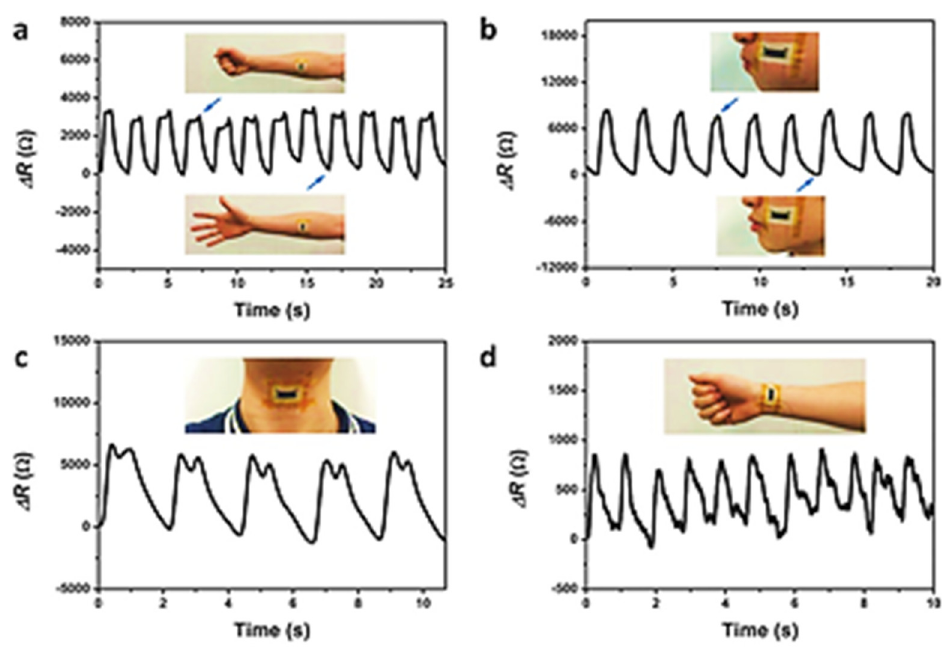
Figure 2. Application of the AuNWs/latex strain sensor in human motion monitoring: ( a ) movement of the forearm muscles; ( b ) movement of the cheeks; ( c ) continuous throat movement while saying “hello”; and ( d ) detecting human wrist pulses [66]. Copyright 2015, John Wiley and Sons. Table 1. Gauge factor of different materials.